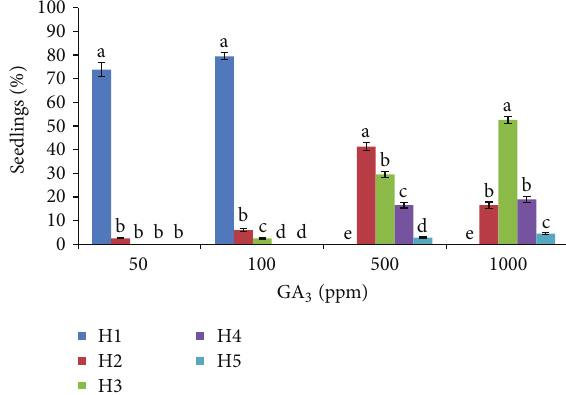
Figure 8: Percentage of Gentiana lutea var. aurantiaca seedlings showing different growth habits for each of the GA 3 doses (50, 100, 500, and 1000ppm). Bars with different letters for each GA 3 doses are significantly different ( 𝑃 = 0.05 ) according to